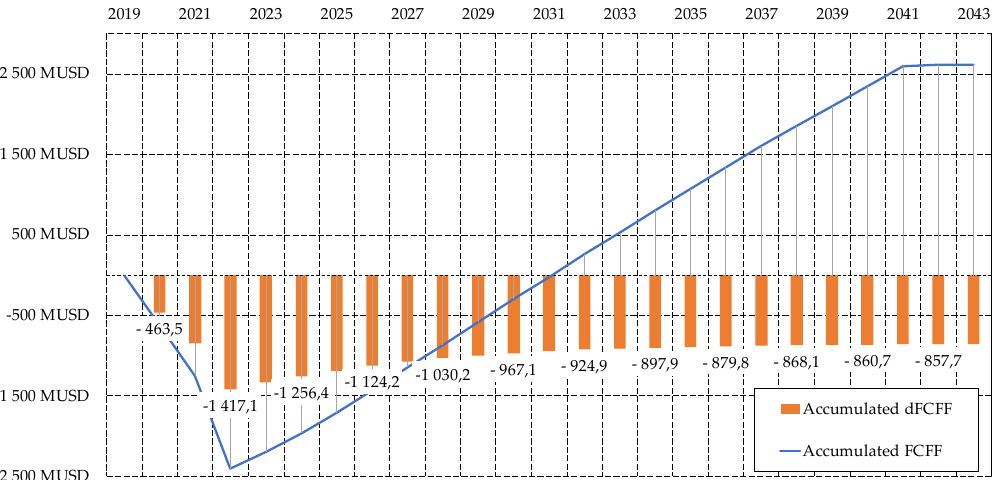
Figure 7. The results of the economic analysis (accumulated cash flow) of scenario 1—PM, FCFF—free cash flow for the firm, dFCFF—discounted FCFF (QVISTORP growth, QVISTORP calculation).